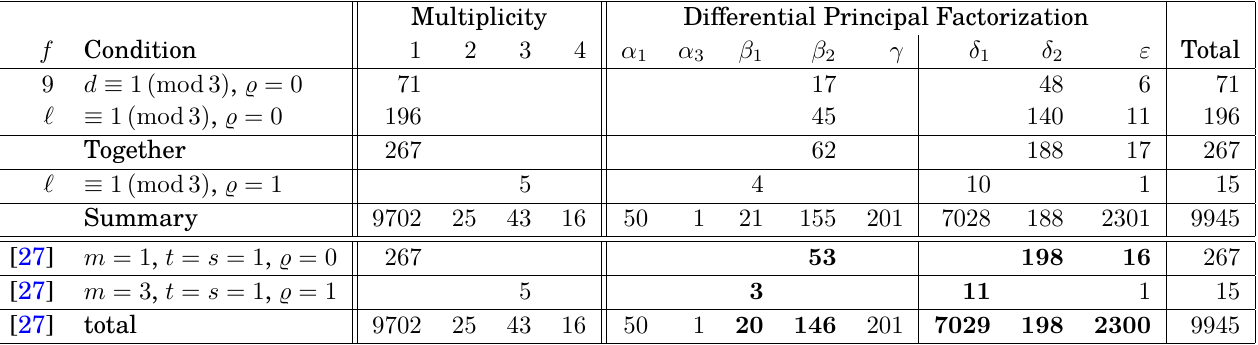
Table 8: Accumulation of rows in Table 6 for comparison with [27, p. 3].